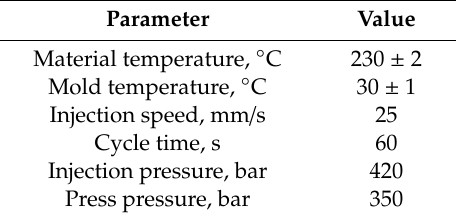
Table 2. Parameters of the injection molding of investigated samples.